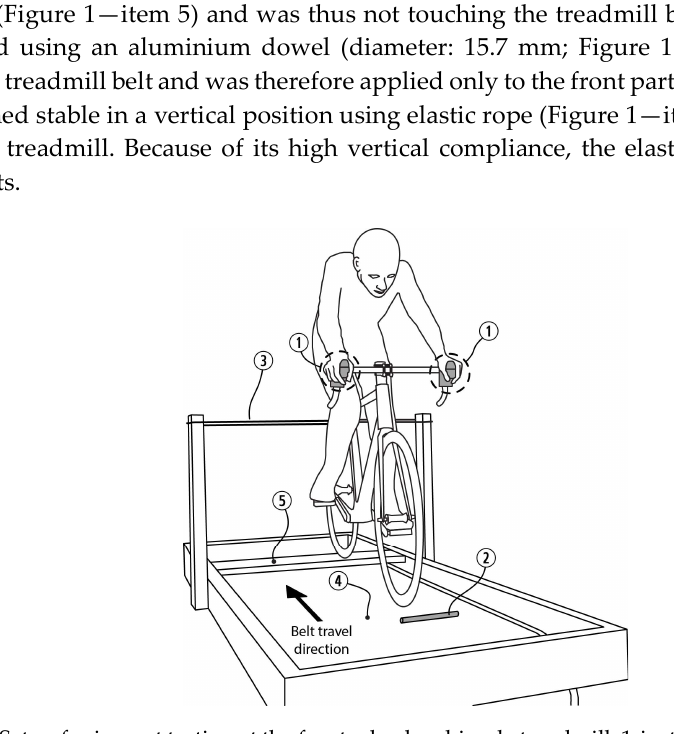
Figure 1. Setup for impact testing at the front wheel on bicycle treadmill. 1-instrumented brake hoods; 2-aluminium dowel; 3-elastic rope; 4-treadmill belt; 5-rear wheel raiser